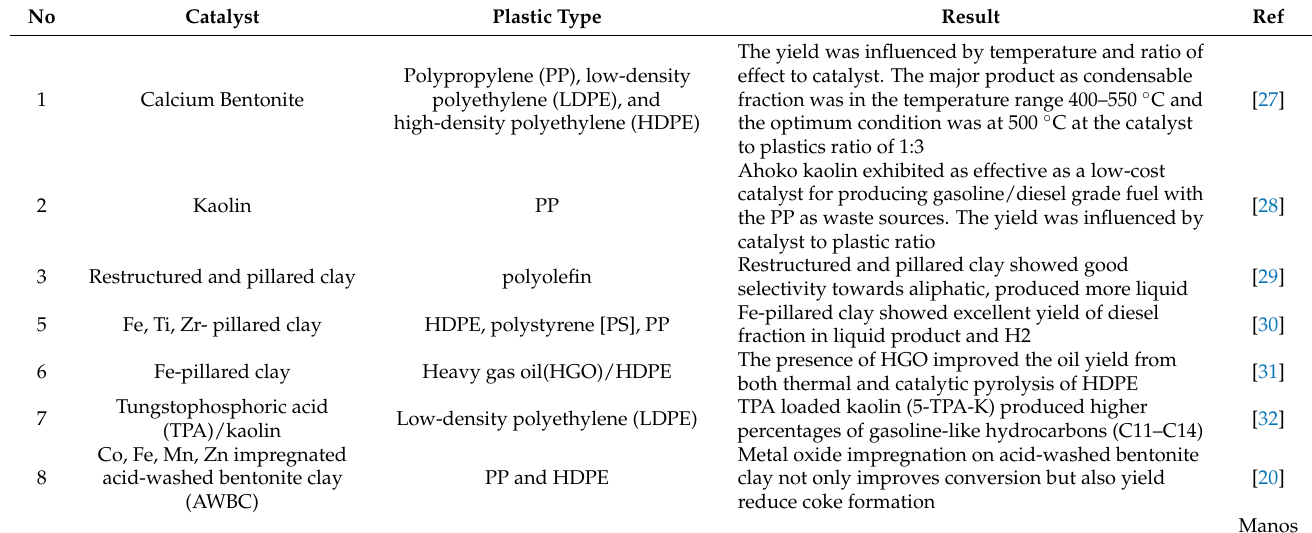
Table 1. Recent works on pyrolysis of plastic waste over clay catalysts.